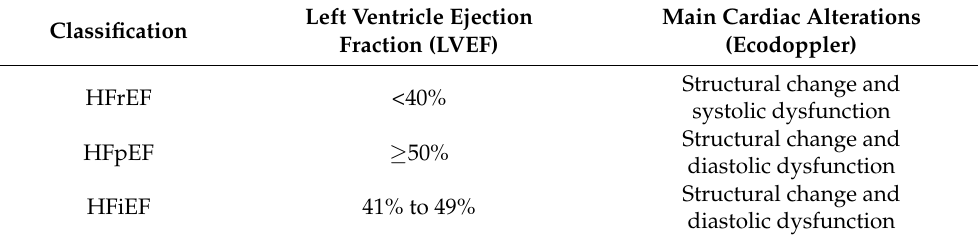
Table 1. Definition of HF, according to left ventricular ejection fraction.